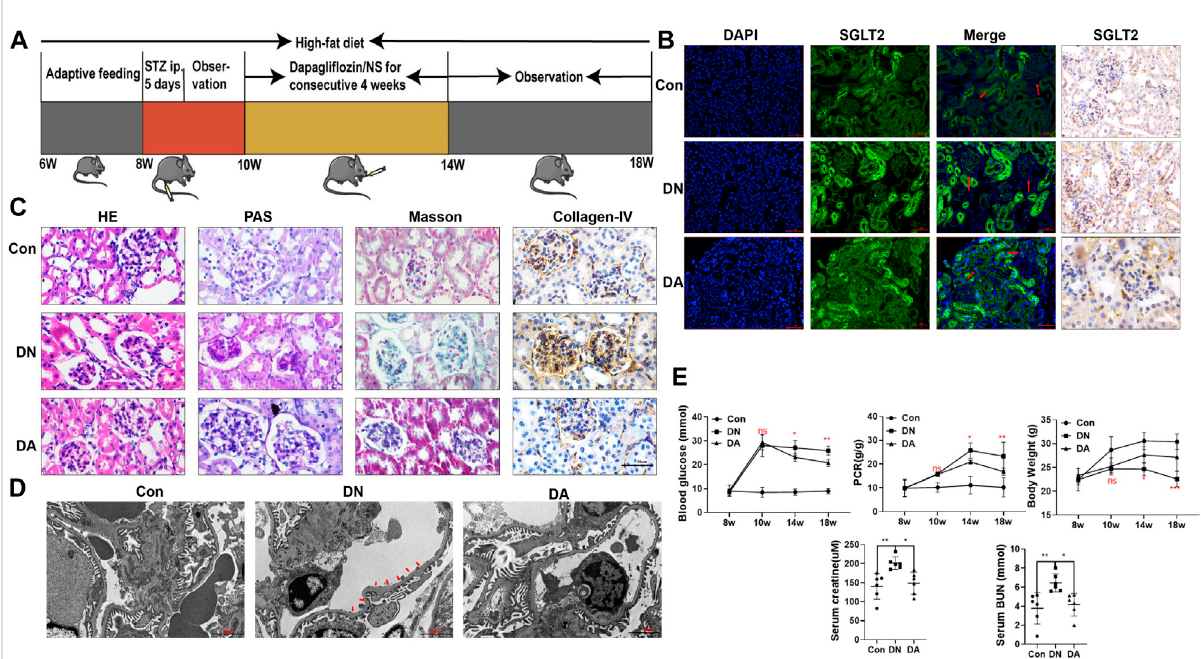
FIGURE 1 Dapagli fl ozin attenuated STZ-induced diabetic kidney injury. (A) Flowchart of the animal experiment ( n = 6/group). (B) IF and IHC staining of SGLT2. (C) Pathologicalstaining:light micrographs of HE,PAS, and Masson stainingand IHCof collagen IV. (D) Representativeelectron micrographs of glomeruli. Areas of basement membrane thickening and podocyte injury are indicated by red arrows. (E) Statistical signi fi cance of BG levels, BW, and PCR among the three groups in the 8th, 10th, 14th, and 18th weeks was performed using two-way ANOVA, and Tukey ’ s algorithm for subsequent multiple comparisons between two groups. In parallel, one-way ANOVA was performed for SCr and BUN levels. STZ: streptozotocin; Con: control group;DN:diabetic nephropathy; DA: dapagli fl ozin-treatedDN group:NS: normal saline; SGLT2: sodium – glucose cotransporter 2;IF: immuno fl uorescent staining; IHC: immunohistochemical staining; one-way ANOVA: one-way analysis of variance; BG: blood glucose; BW: body weight; PCR: urinary total protein to creatinine ratio; SCr: serum creatinine; BUN: blood urea